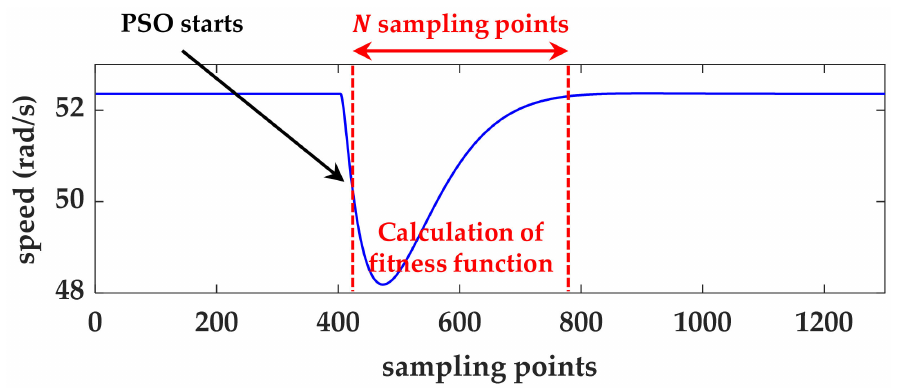
Figure 4. Operation of the PSO